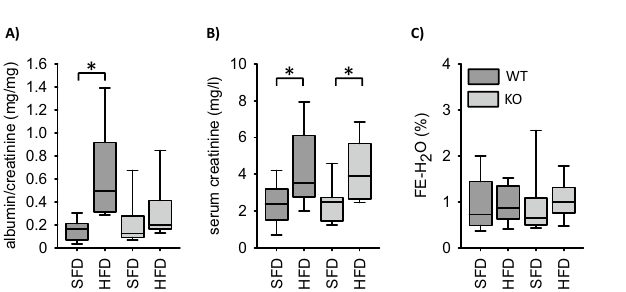
Figure 6. Impact of HFD-diet on functional renal parameters in the EC-EGFR-model. ( A ) Urinary albumin excretion. ( B ) Serum creatinine concentrations. ( C ) Fractional water excretion (FE). Number of animals: N = 10 for each experimental group. *p < 0.05. SFD standard diet, HFD high fat diet, WT wildtype, KO